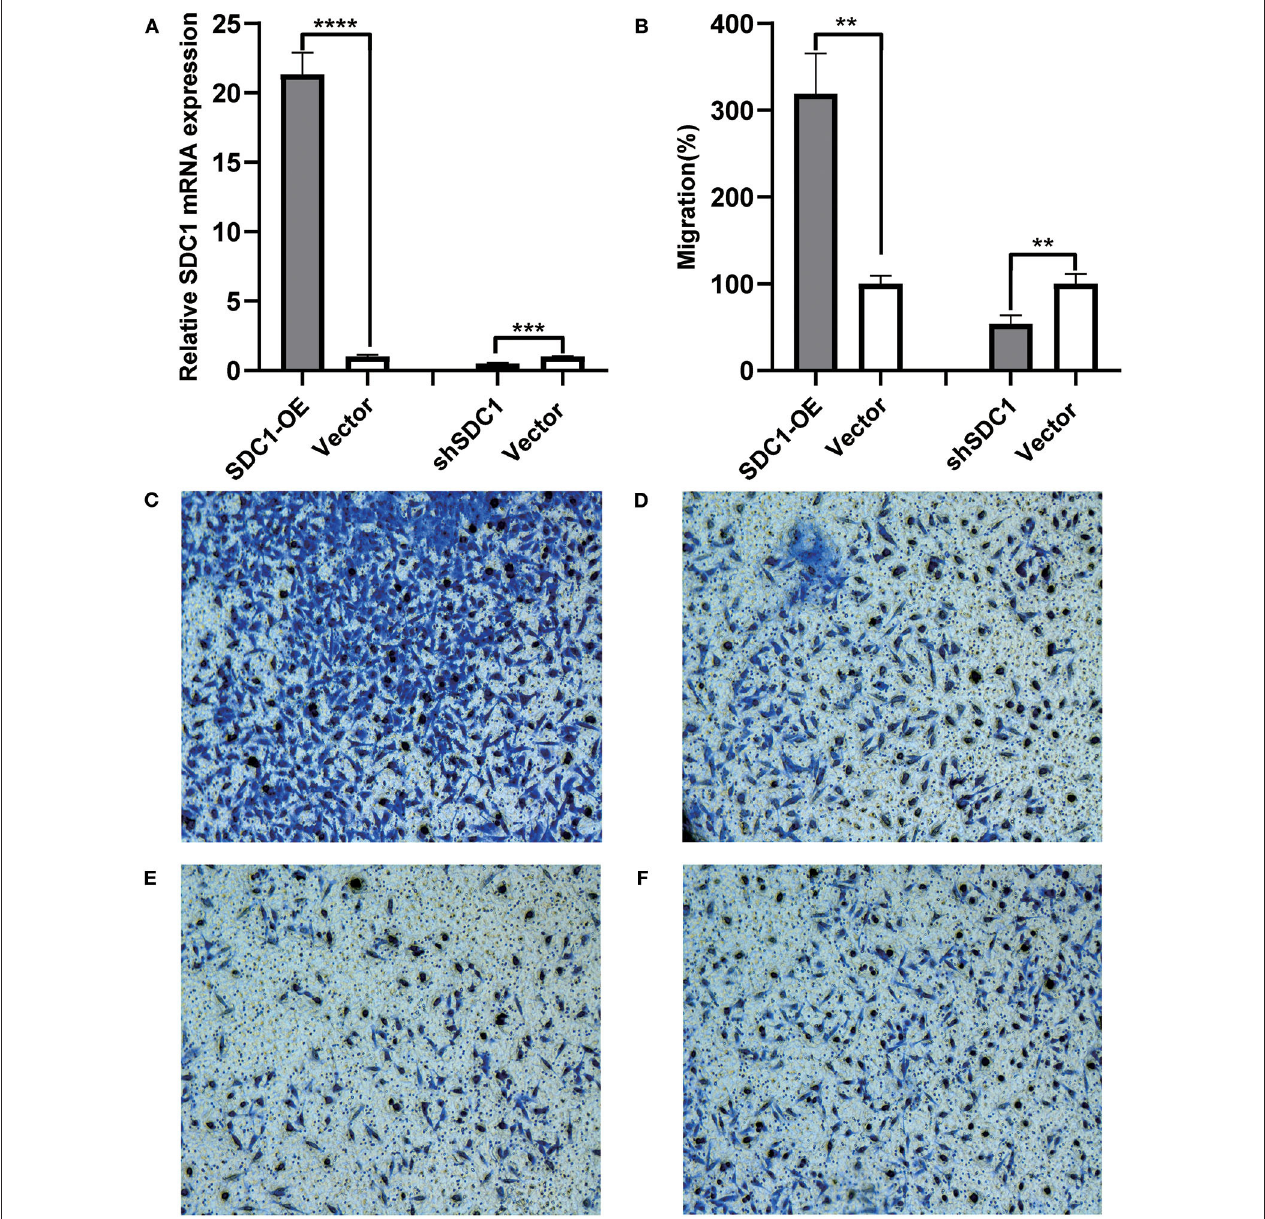
FIGURE 5 | Influence of SDC1 overexpression and knockdown on the migration of triple-negative breast cancer (TNBC) cells. (A) The relative mRNA expression of SDC1 was significantly elevated in SDC1-OE-MDA-MB-231 cells, compared with vector-MDA-MB-231 cells ( P < 0.0001). The relative mRNA expression of SDC1 was significantly reduced in shSDC1-MDA-MB-231 cells, compared with vector-MDA-MB-231 cells ( P = 0.0006). (B) The ratio of migrated cells was significantly elevated in DC1-OE-MDA-MB-231 cells, compared with vector-MDA-MB-231 cells ( P = 0.0014). The ratio of migrated cells was significantly reduced in shSDC1-MDA-MB-231 cells, compared with vector-MDA-MB-231 cells. ( P = 0.0061). (C–F) The images of bottom surface of upper chambers of SDC1-OE-MDA-MB-231 (C) , ShSDC1-MDA-MB-231 (E) , and the vector-MDA-MB-231 cells (D,F) . Cells were cultured in the upper chamber of the transwell chambers for 48h and then stained with Diff-Quick dye. ** P < 0.01, *** P < 0.001 **** P < 0.0001.